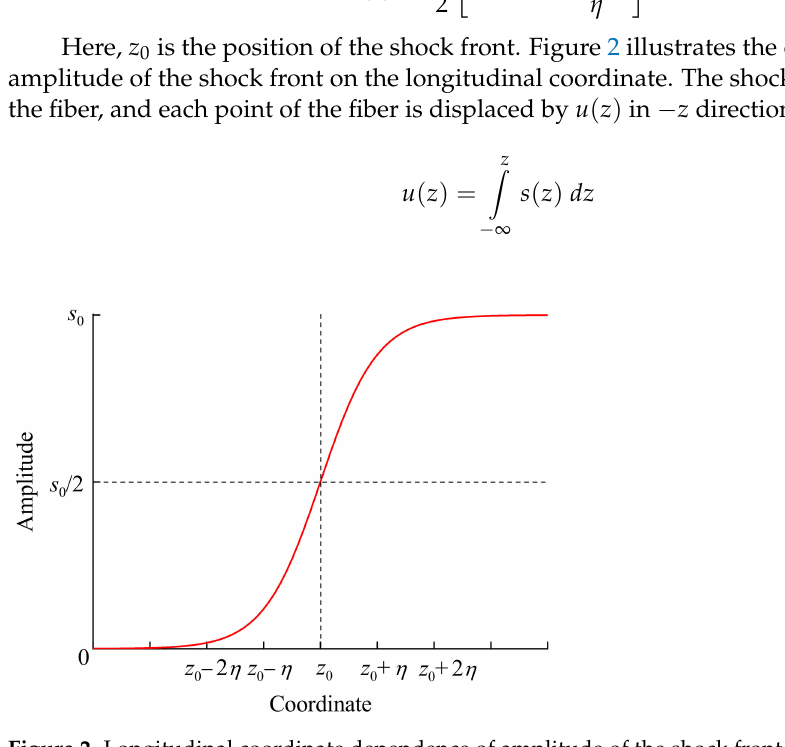
Figure 2. Longitudinal coordinate dependence of amplitude of the shock